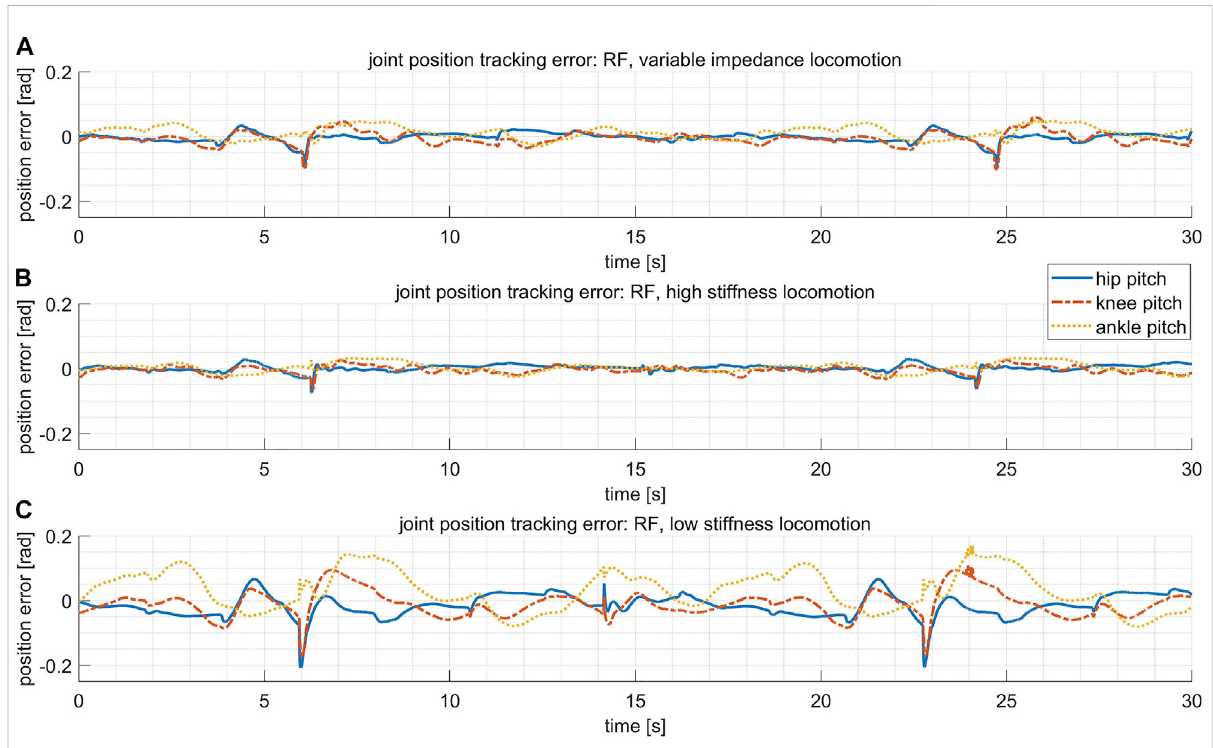
FIGURE 10 The joint position tracking error of the leg RF in three comparative tests. (A) In the variable stiffness locomotion. (B) In the high stiffness locomotion. (C) In the low stiffness